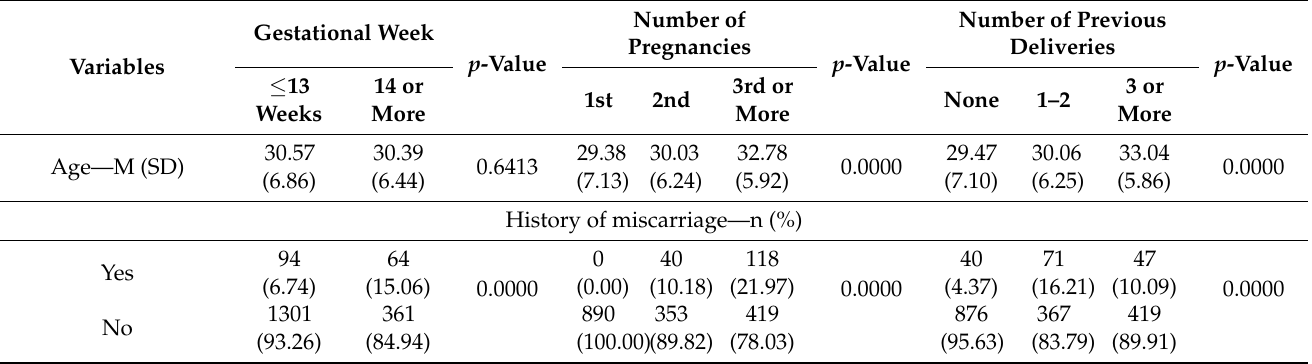
Table 4. Analysis of the relationship between gestational week, number of pregnancies and number of previous deliveries and selected